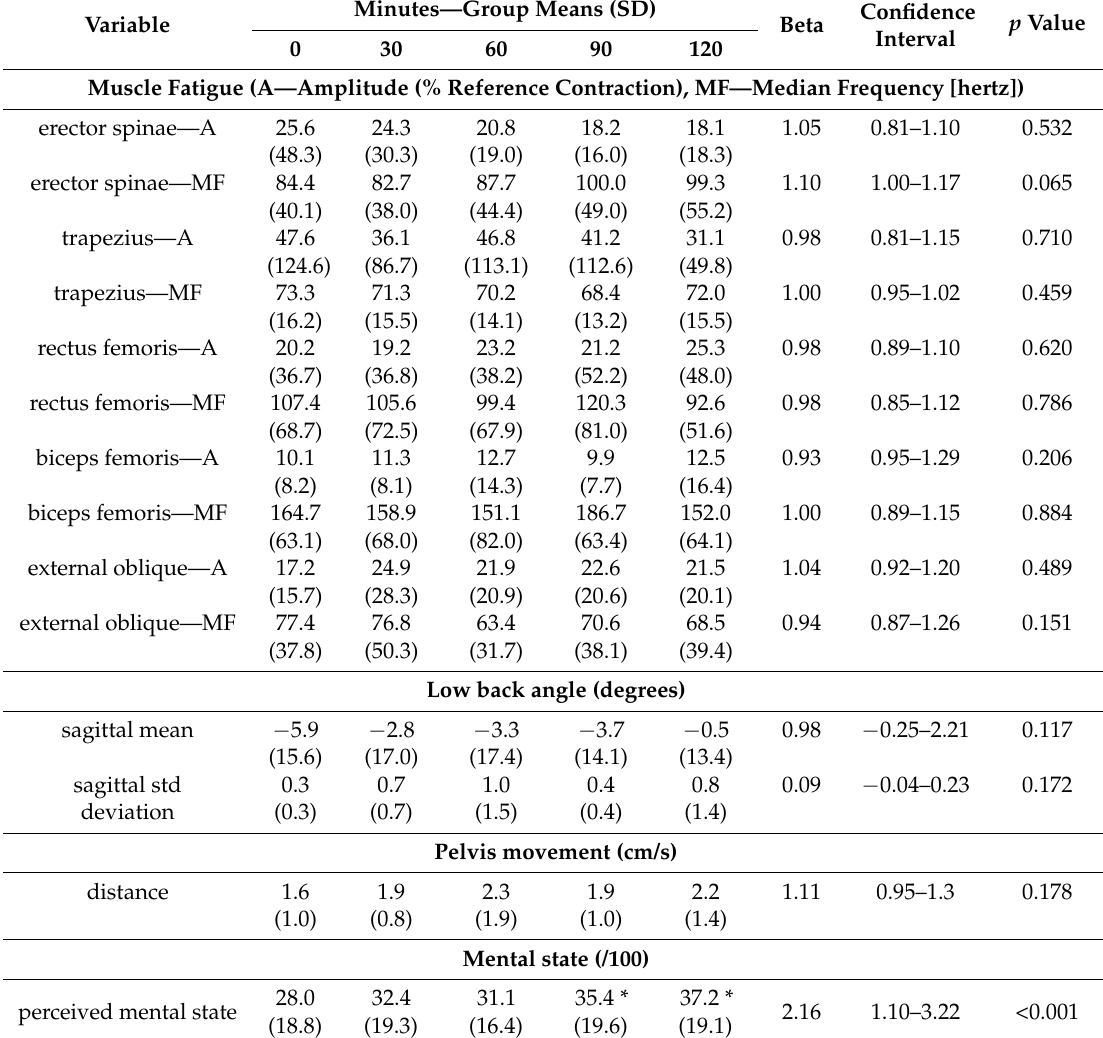
Table 3. Muscle fatigue, low back angle and movement, calf swelling and mental state [mean (standard deviation)] over 2 h of prolonged standing with coefficient (Beta) for effect of